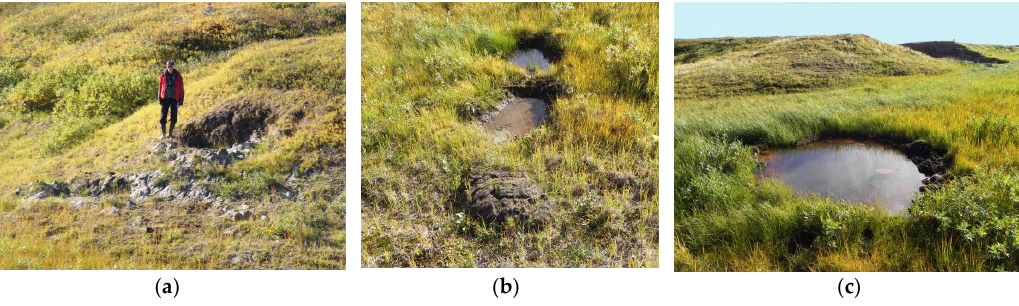
Figure 13. Impact hollows in the vicinity of AntGEC: ( a ) impact hollow with a diameter of 2.5 m on the slope of the gully directly opposite AntGEC, 34 m to SW of the AMP. Below the impact hollow are fragments of deposits, either ejected from AntGEC, or extruded out of the slope forced by the impactor (photograph by M. O. Leibman, August 2016); ( b ) two impact hollows 0.5–0.8 m in diameter filled with water, in the foreground a block of sod, either squashed out of the surface by the impactor, or ejected from AntGEC (photograph by A. V. Khomutov, August 2016); ( c ) the largest (diameter four meters) impact hollow filled with water in the bottom of the gully, 55 m to the NNW of the AMP (photograph by A. V. Khomutov, August 2016).